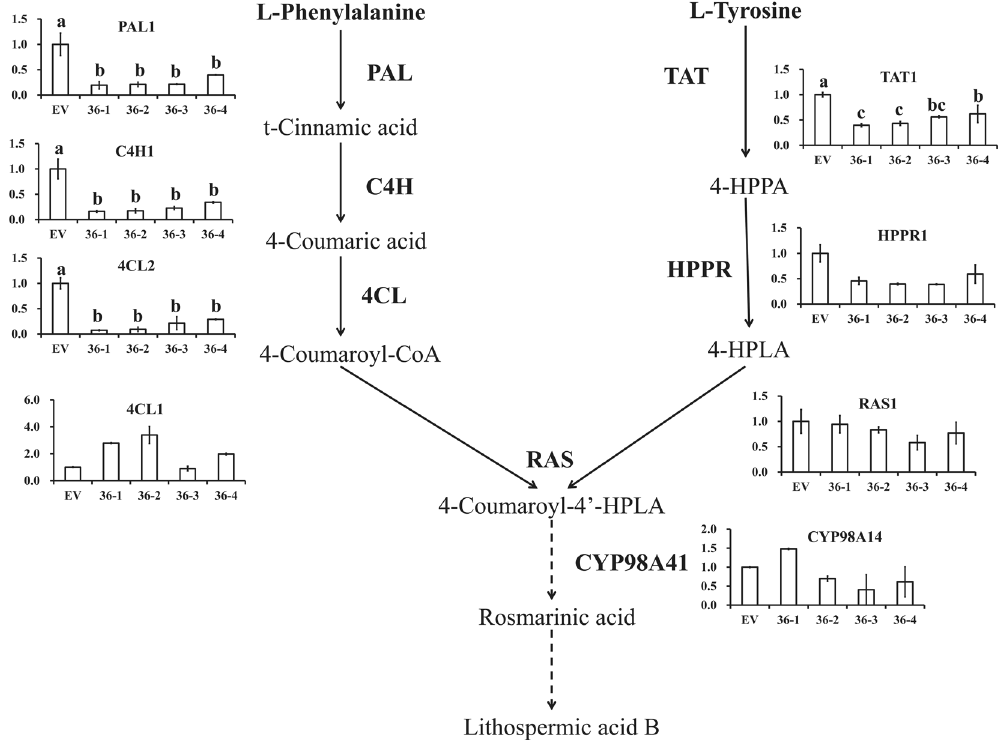
Figure 6. Relative expression level of phenolic acid biosynthesis pathway genes in transgenic hairy roots. Each line has two biological repeats and each biological repeat has three technological repeats. All values are expressed as means ±